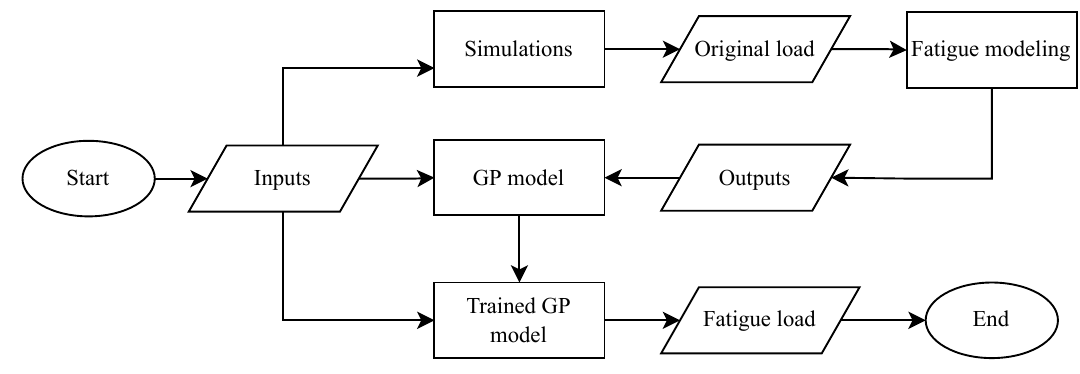
Figure 1. Fatigue load prediction flowchart.